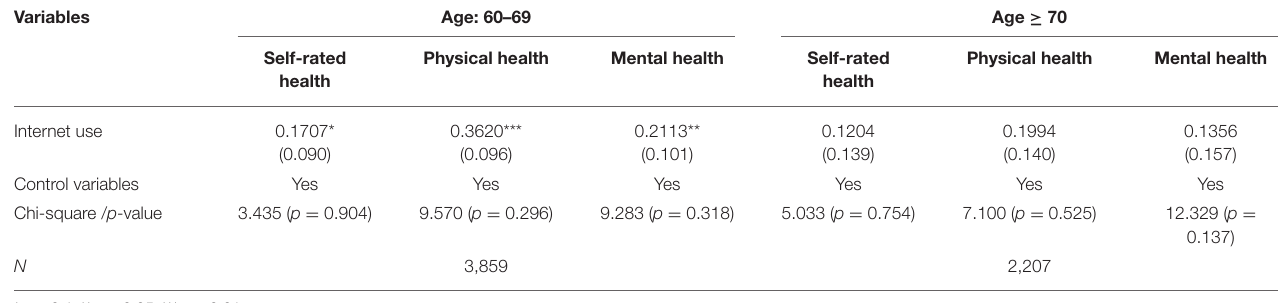
TABLE 6 | Regression results by household.